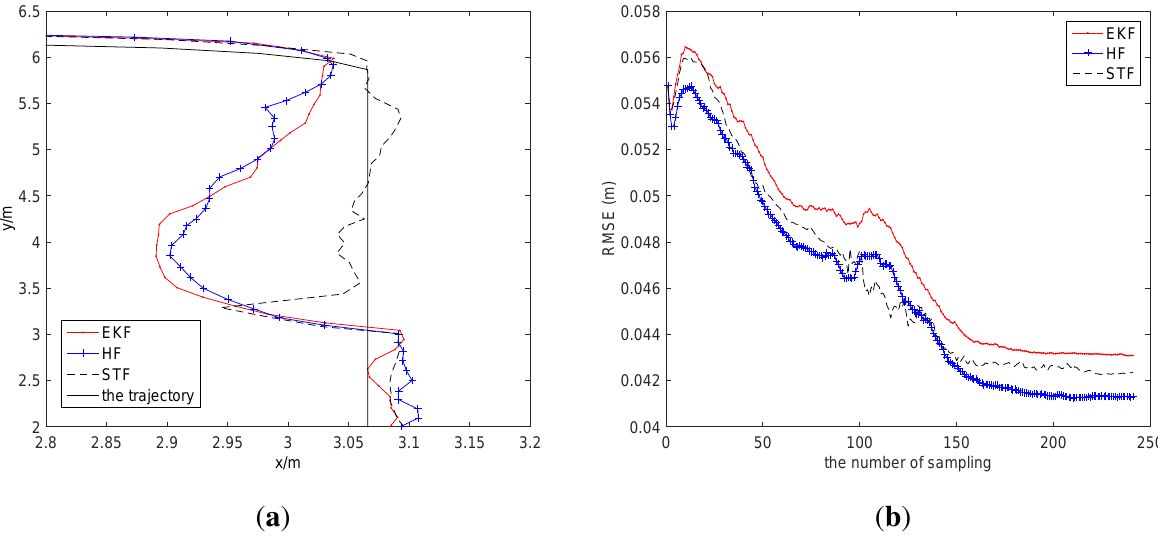
filter (HF) and the strong tracking filter (STF). ∞